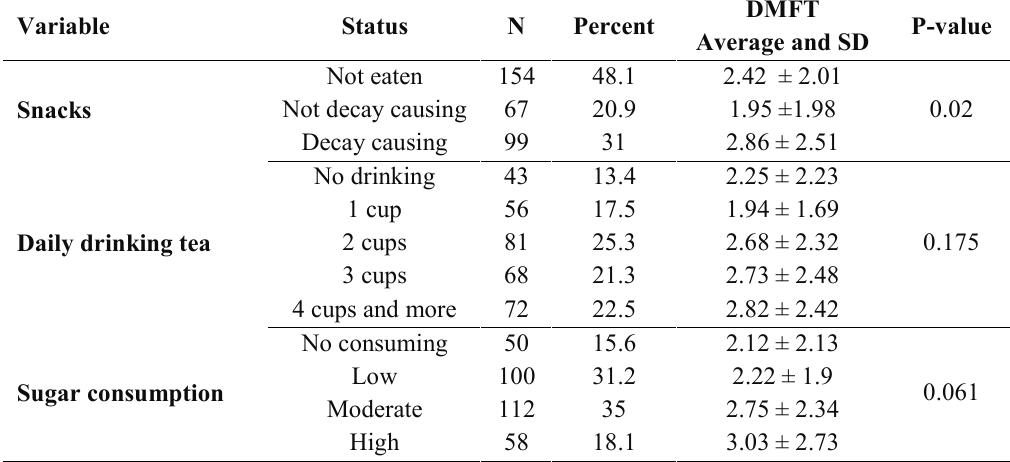
Table 4 the status of DMFT in students and the use of snacks, tea and sugar